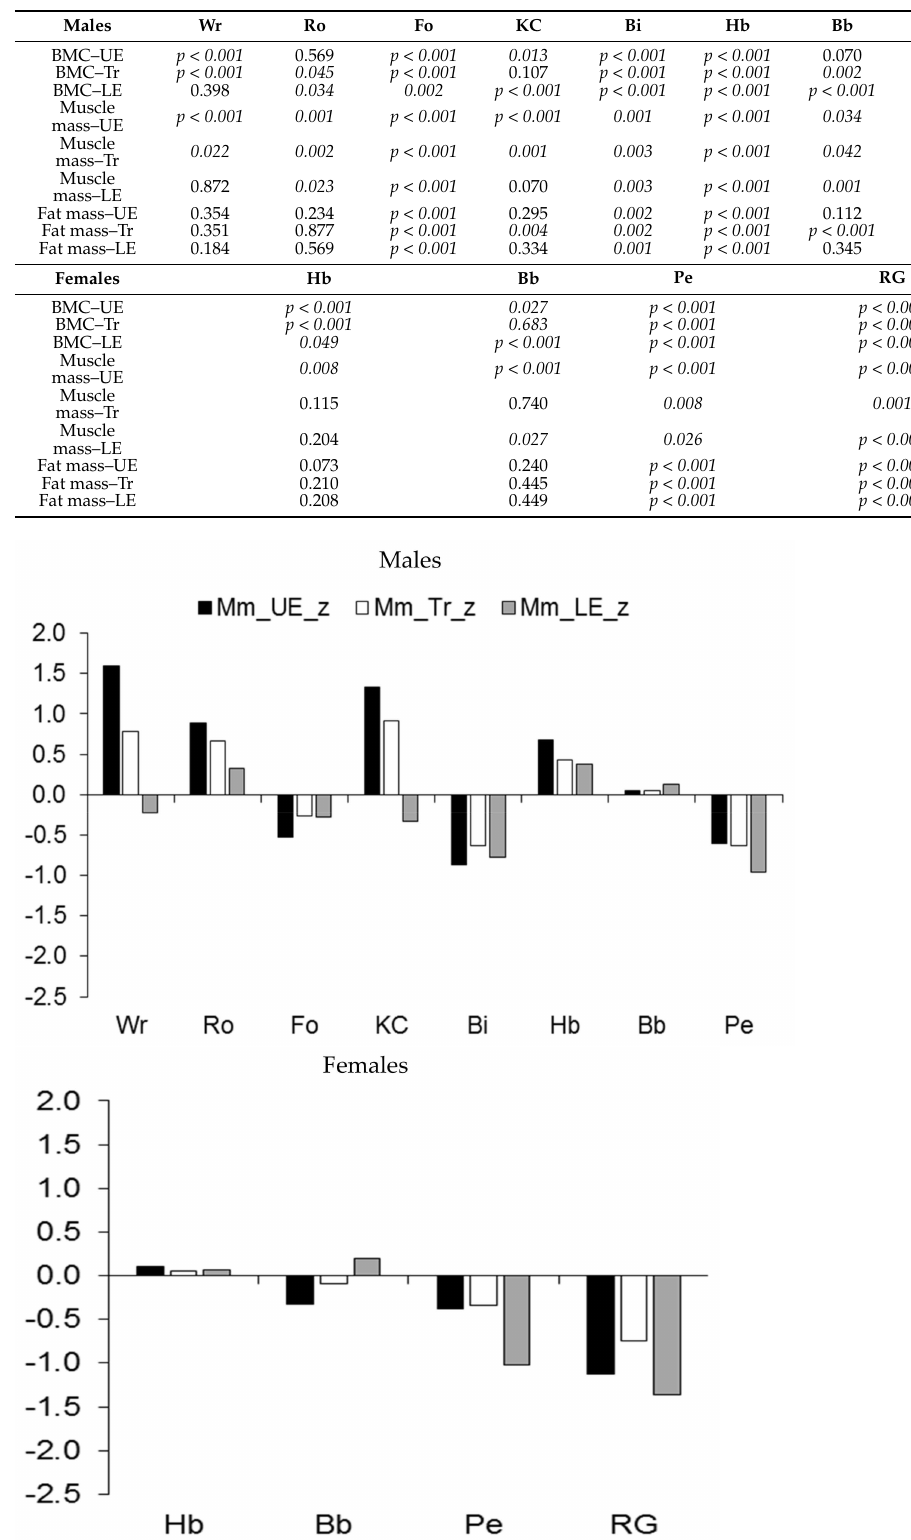
Table 5. Significance level in Wilcoxon signed-rank test (significant values in italics) of body mass components in the studied body regions (z-values) in young athletes by the type of sport.